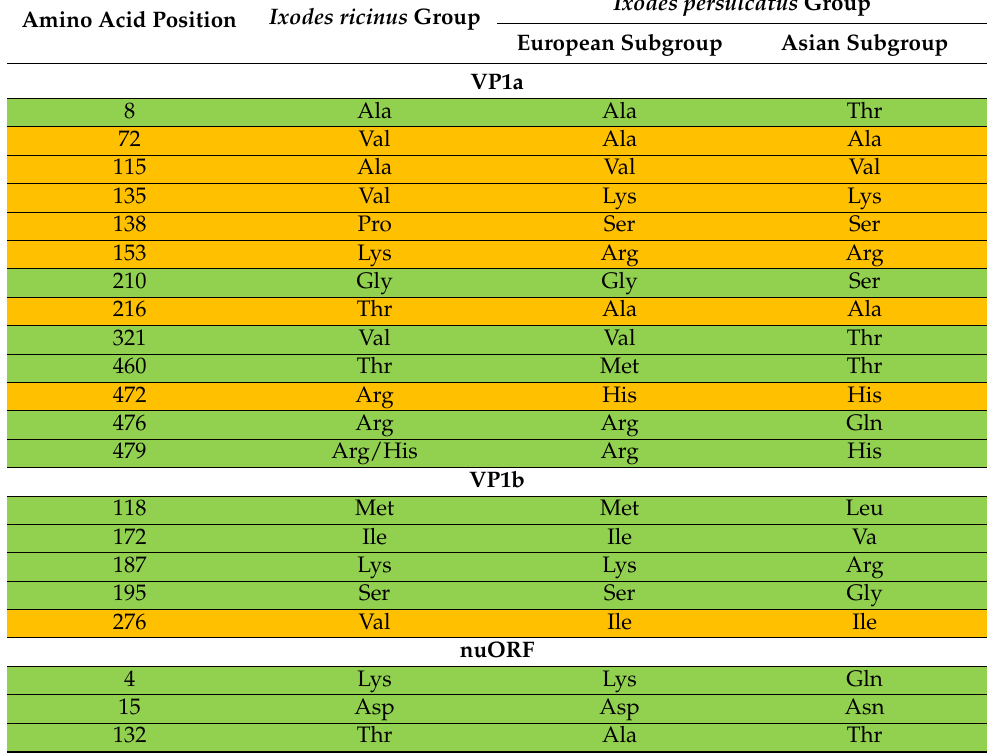
Table 3. Specific amino acid substitutions in the Alongshan virus VP1a, VP1b and novel upstream open reading frame (nuORF) proteins detected in the Ixodes ricinus group and European and Asian Ixodes persulcatus subgroups. Amino Acid